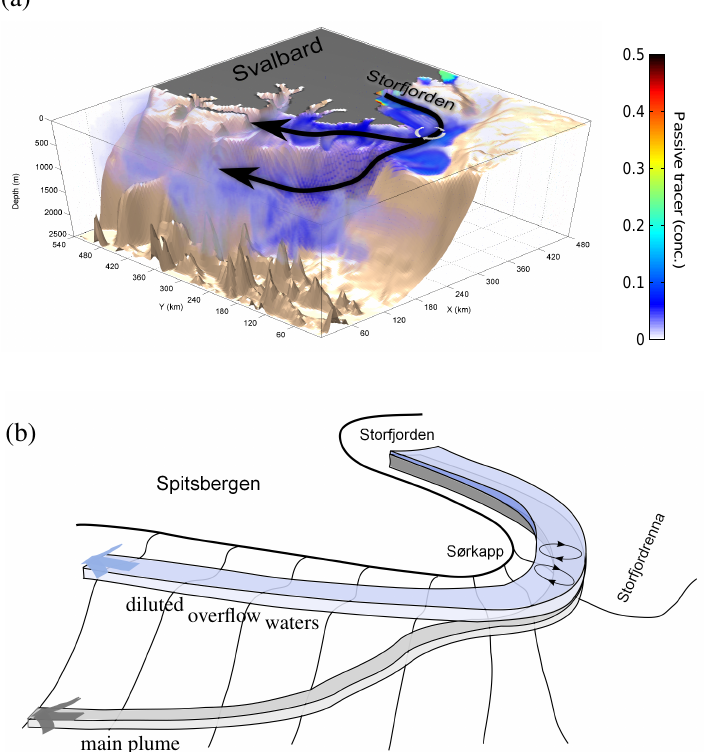
Fig. 9. (a) Three-dimensional volume rendering of tracer concentration for the same day of the tidal run in Fig. 4b (same colour scheme). (b) Schematic of tidal dispersion of the Storfjorden overflow plume. Tidally induced shear dispersion near Sørkapp diverts the lighter fractions of plume water from its upper layer onto the shelf.